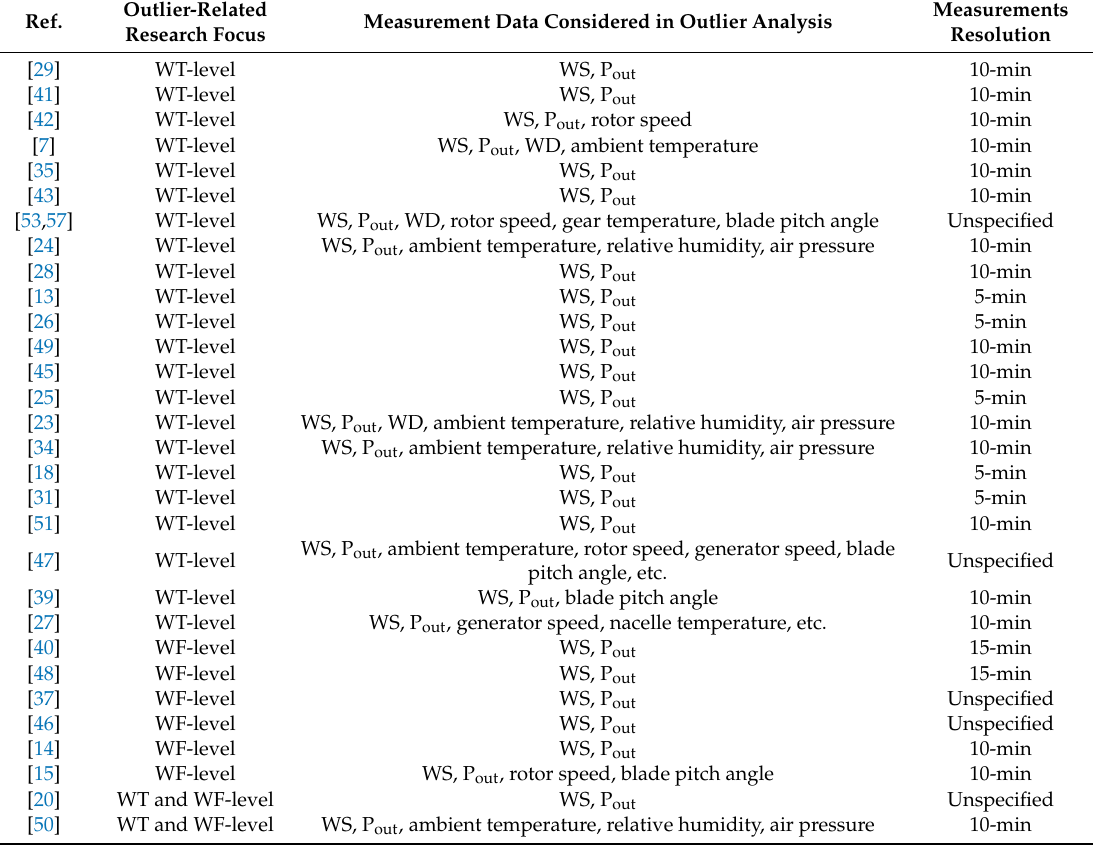
Table 1. Summary of wind turbine and wind farm measurements in available outlier-related literature.